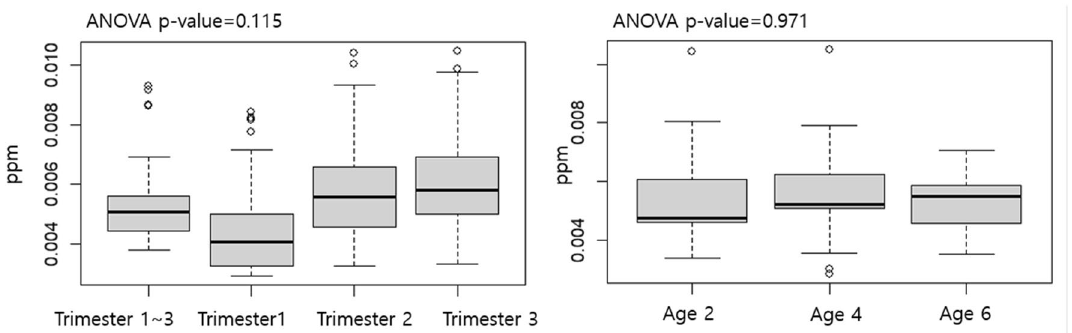
Figure 1. The prenatal SO 2 exposure according to the trimester (left) and postnatal SO 2 exposure according to the ages of 2, 4 and 6 years